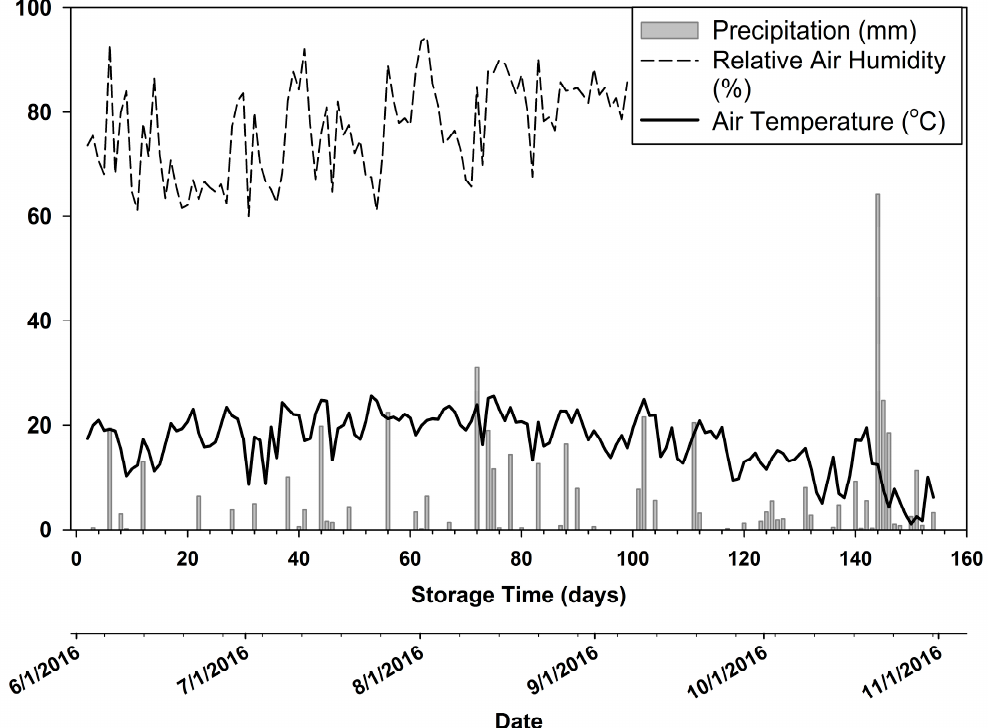
Figure 2. Daily weather patterns at the site where willow and poplar chips were stored in piles for five months (day zero is 31 May 2016).